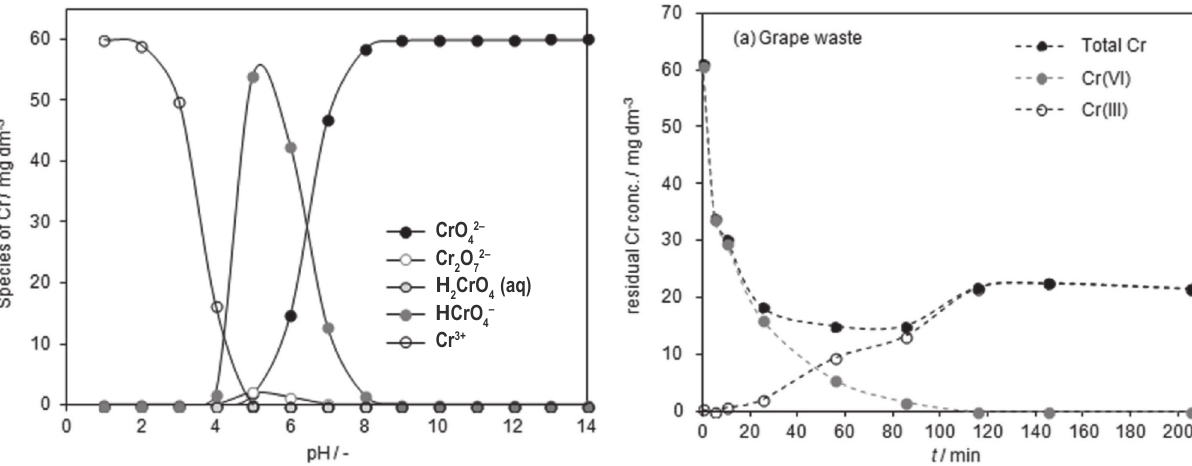
Fig. 3 – Concentration of Cr species depends on pH (γ mg dm –3 ) using MINTEQ software